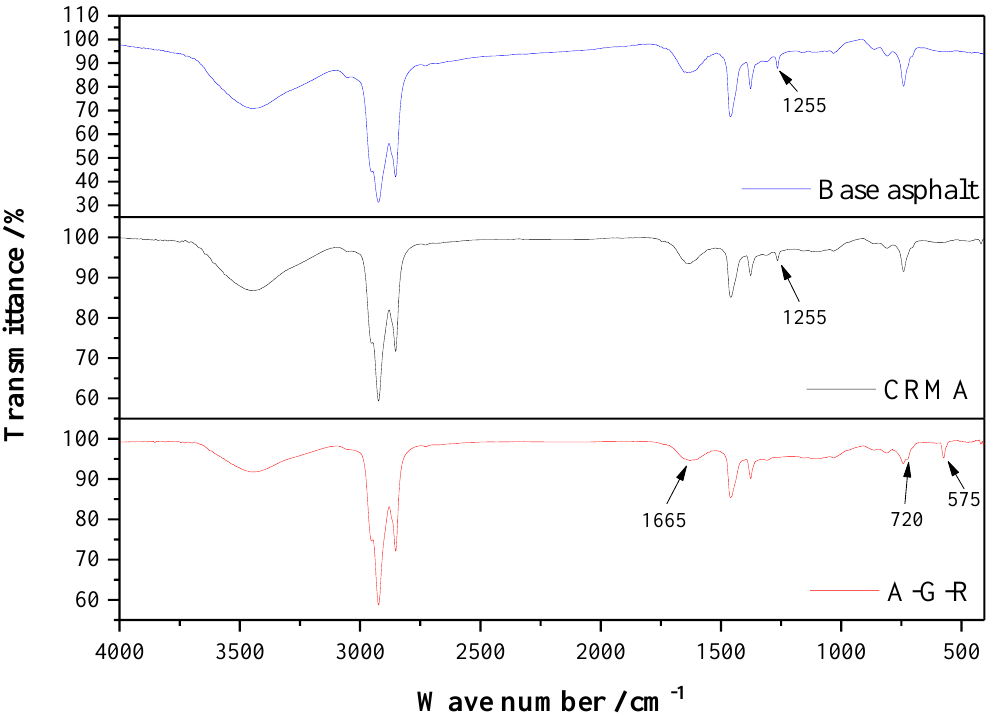
Figure 3. Infrared absorption spectrums of CRMA and A–G–R.